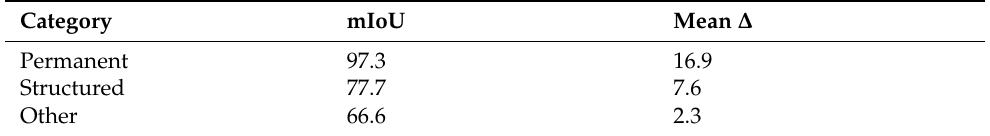
Table 5. Improvement Relative to Structure. Classwise IoU and mean improvement of our model compared to the single-year model according to the rotation structure of the cultivated crops.